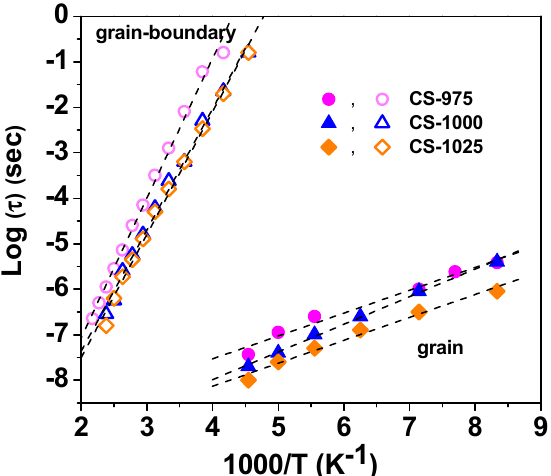
Figure 10. Temperature dependence of the relaxation time determined from the modulus spectra.